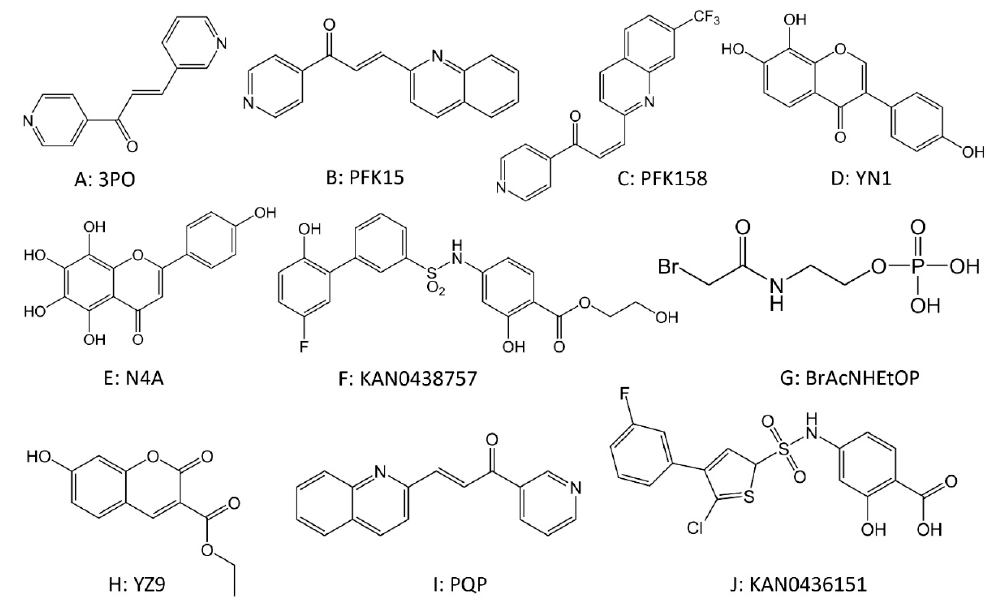
Figure 5. The chemical structures of drugs targeting phosphofructokinase.